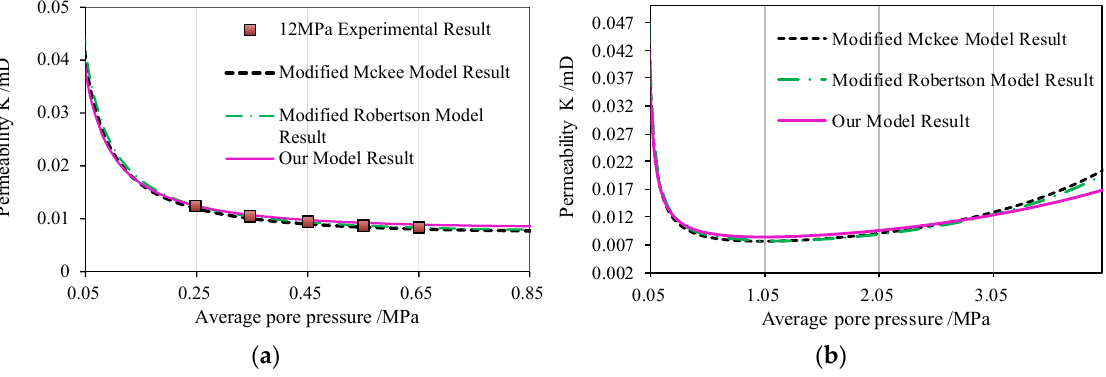
Figure 11. Calculation results of the permeability models under a hydrostatic stress of 12 MPa and the corresponding experimental data of sample M1. ( a ) Comparison of the permeability models with the experimental data. ( b ) Calculation results for a wider pore pressure range.